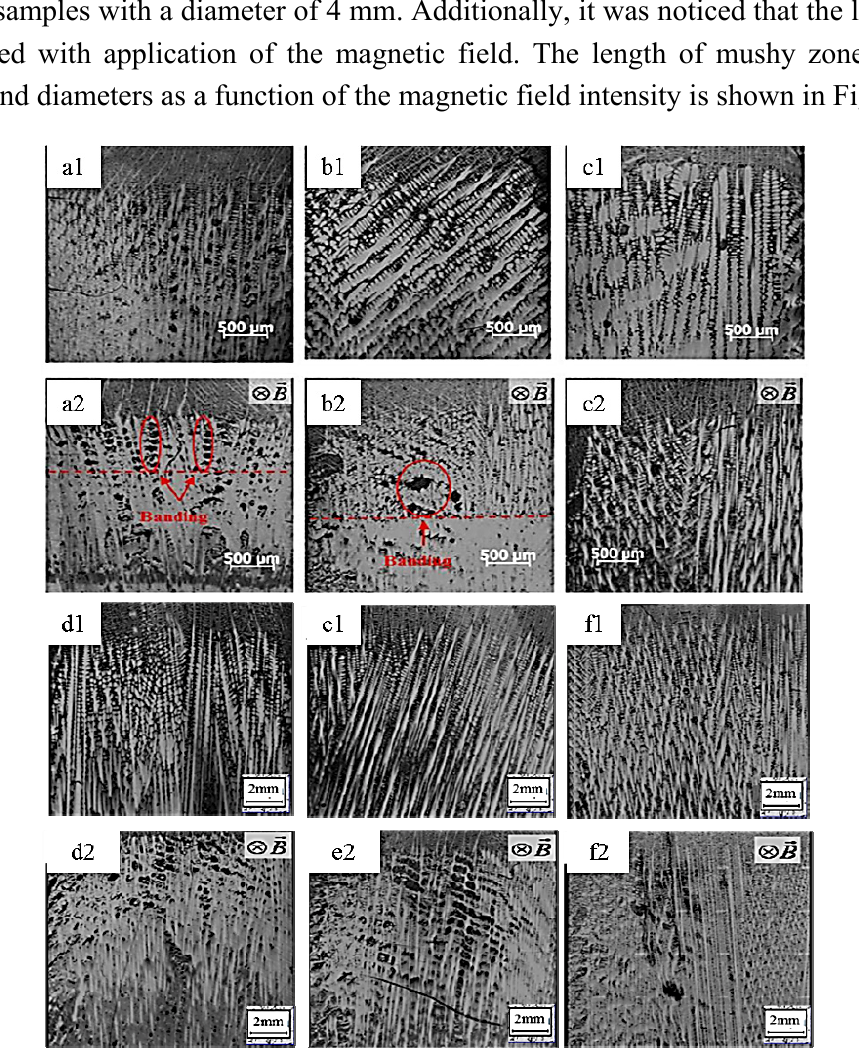
Figure 1. Longitudinal microstructure of directionally solidified superalloy at a temperature gradient of 80 K·cm − 1 without and with a 0.5 T transverse magnetic field (  ): ( a1 ) 0 T, 5 μ m·s − 1 , diameter of 4 mm; ( a2 ) 0.5 T, 5 μ m·s − 1 , diameter of 4 mm; ( b1 ) 0 T, 10 μ m·s − 1 , diameter of 4 mm; ( b2 ) 0.5 T, 10 μ m·s − 1 , diameter of 4 mm; ( c1 ) 0 T, 20 μ m·s − 1 , diameter of 4 mm; ( c2 ) 0.5 T, 20 μ m·s − 1 , diameter of 4 mm; ( d1 ) 0 T, 5 μ m·s − 1 , diameter of 12 mm; ( d2 ) 0.5 T, 5 μ m·s − 1 , diameter of 12 mm; ( e1 ) 0 T, 10 μ m·s − 1 , diameter of 12 mm; ( e2 ) 0.5 T, 10 μ m·s − 1 , diameter of 12 mm; ( f1 ) 0 T, 20 μ m·s − 1 , diameter of 12 mm; ( f2 ) 0.5 T, 20 μ m·s − 1 , diameter of 12